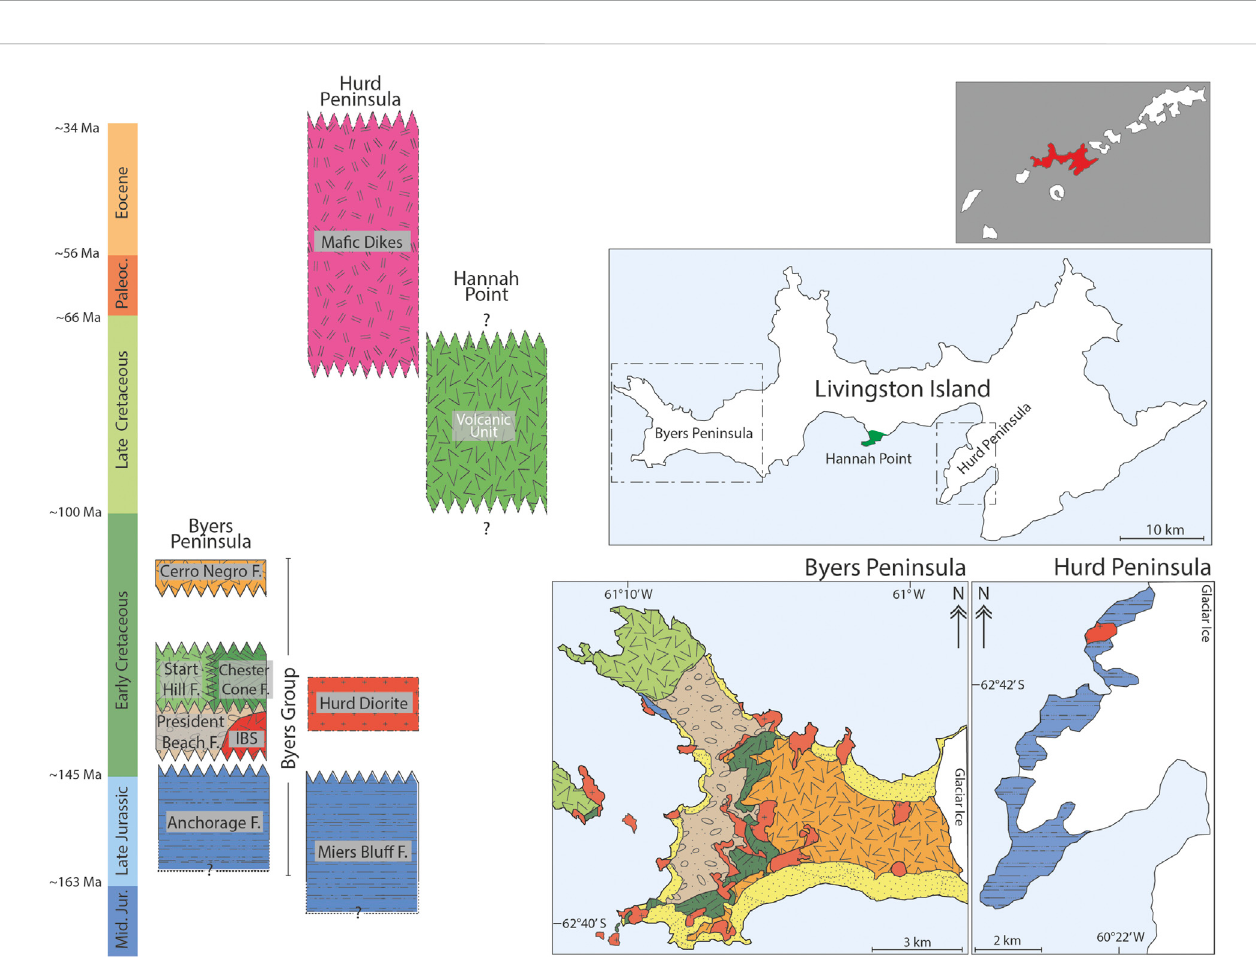
FIGURE 7 Revised geological map of Byers and Hurd peninsulas, Livingston Island, modi fi ed from Hathway and Lomas (1998), Hervé et al. (2006) and Gao et al. (2021).